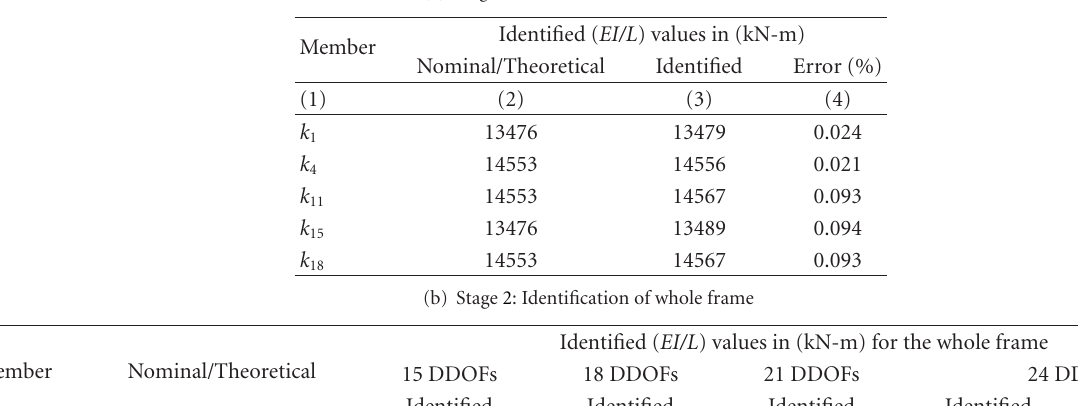
Table 1: Sti ff ness parameter ( EI/L ) identification for defect-free frame using